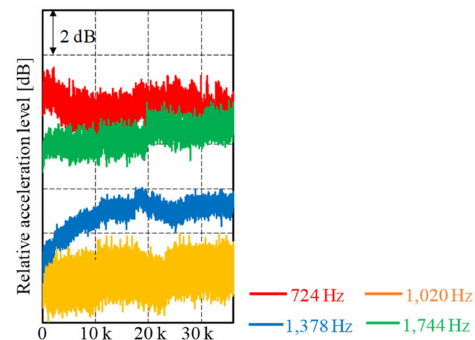
Figure 23. Vibration time-series data under the damaged-bearing condition: In this simulation study, the transition of the energy levels from the normal condition (Figure 19a) to this anomaly condition is simulated to linearly change from one state to the other when operating the lifter continuously for 780